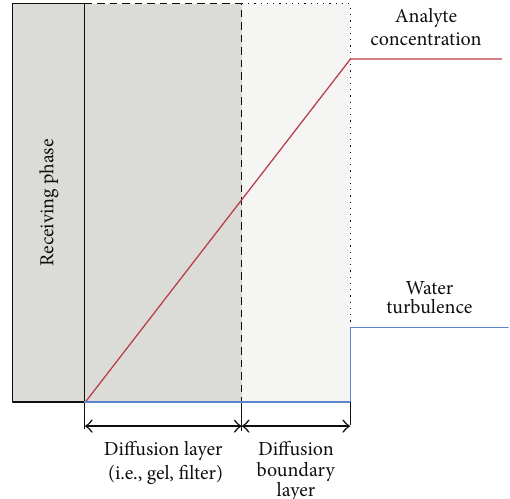
Figure 3: Schematic representation of the concentration gradient that forms over the diffusional